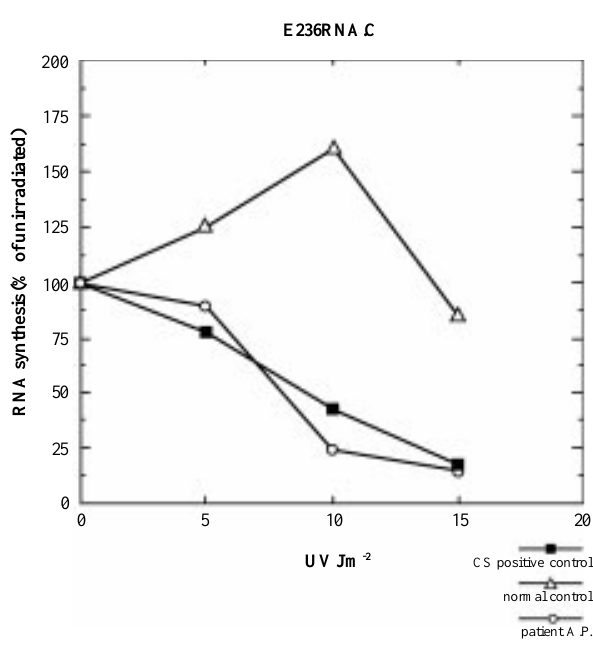
Figure 2 - RNA synthesis in cultured fibroblasts (from patient, CS positive control and normal control) measured by the incorporation of 3 H uridine into RNA 24 h after exposure to UV-C radiation. Results are expressed as the percentage of the RNA synthesis observed in non-irradiated fibroblasts.